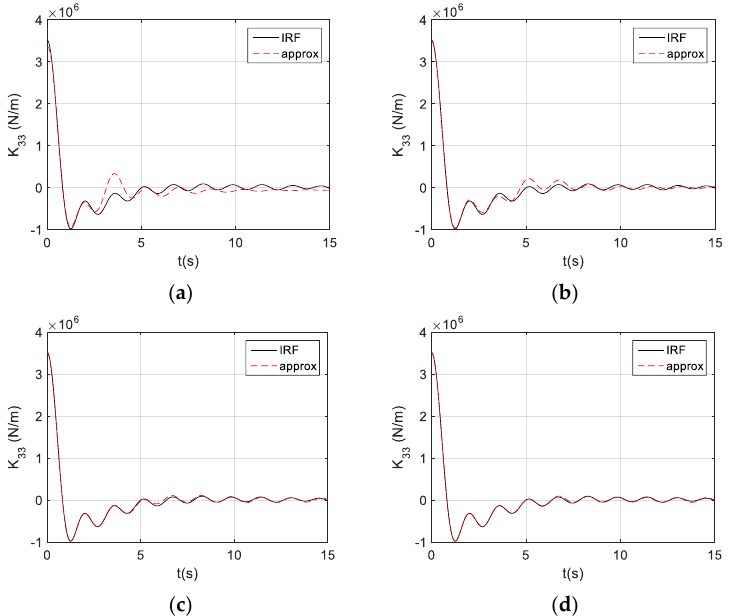
Figure 13. Approximation of impulse function vs. order of Prony function. ( a ) 𝑁 0 = 5; ( b ) 𝑁 0 = 6; ( c ) 𝑁 0 = 8; ( d ) 𝑁 0 = 10. ( c ) N 0 = 8; ( d ) N 0 =